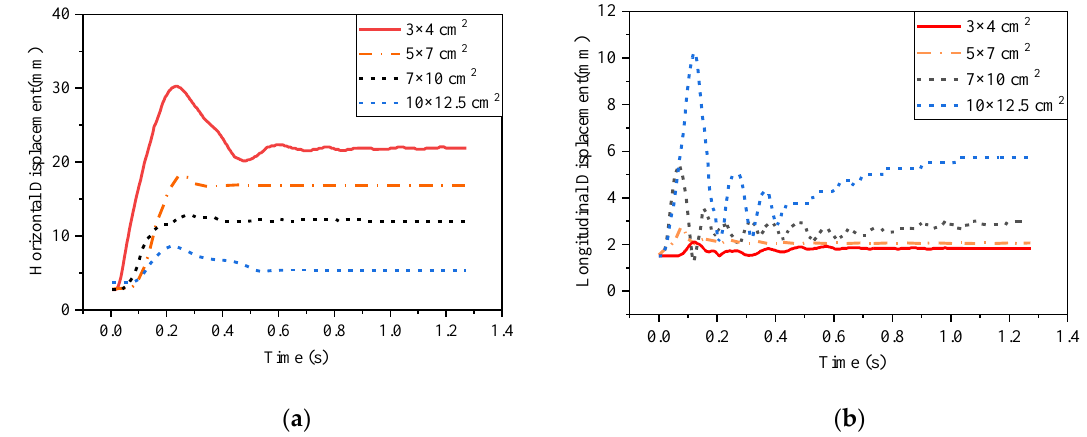
Figure 9. Movement displacement of four sizes of aluminum sheets. ( a ) Horizontal displacement of aluminum sheets; ( b ) longitudinal displacement of aluminum sheets.